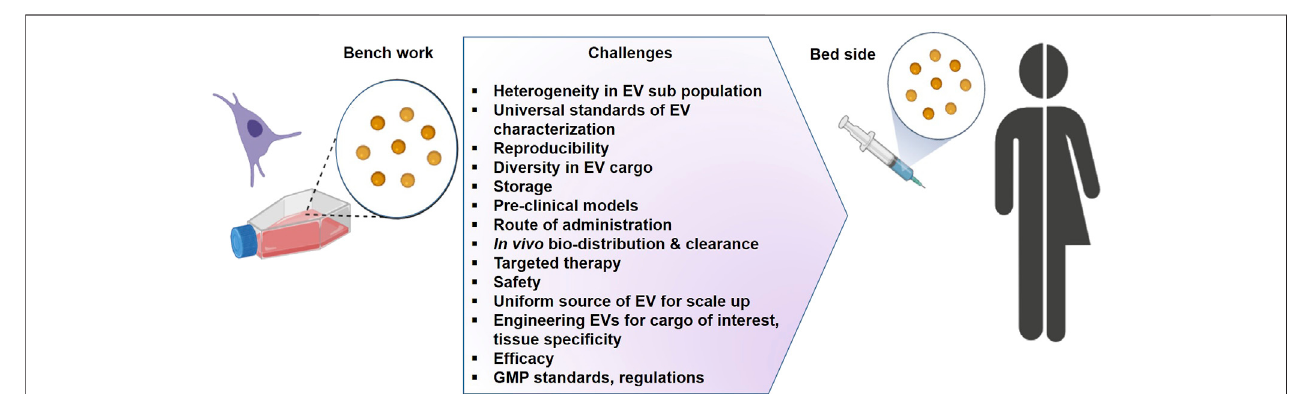
FIGURE 4 | The challenges for the development of extracellular vesicles as therapeutics (Graphic adapted from BioRender.com).